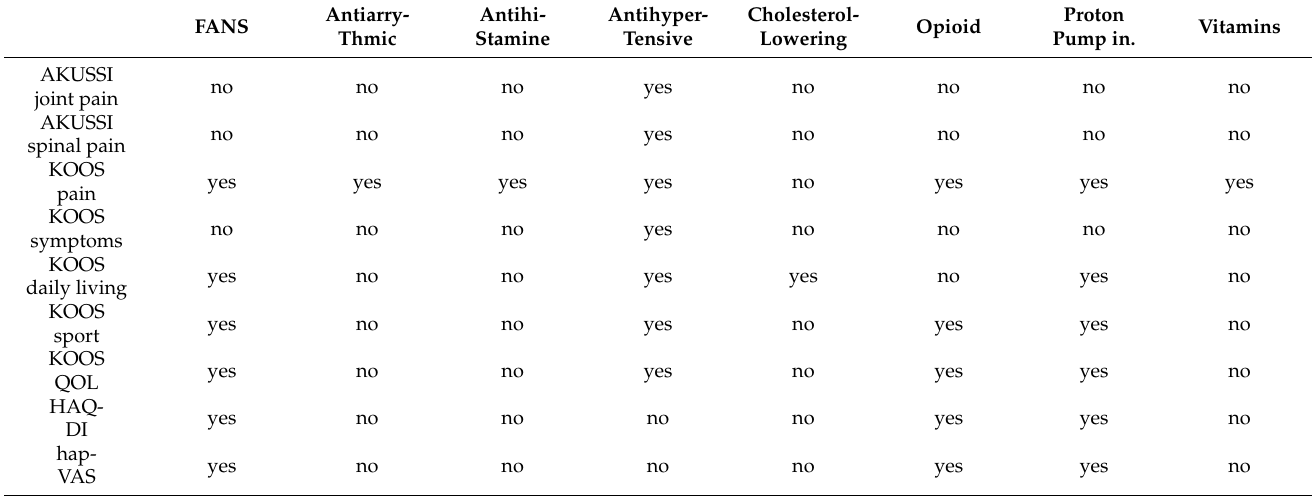
Table 3. Evidence of correlation between the drugs considered in this analysis and the QoL scores; while “yes" means that the correlation is significant, “no" indicates that with the available data there is no evidence of